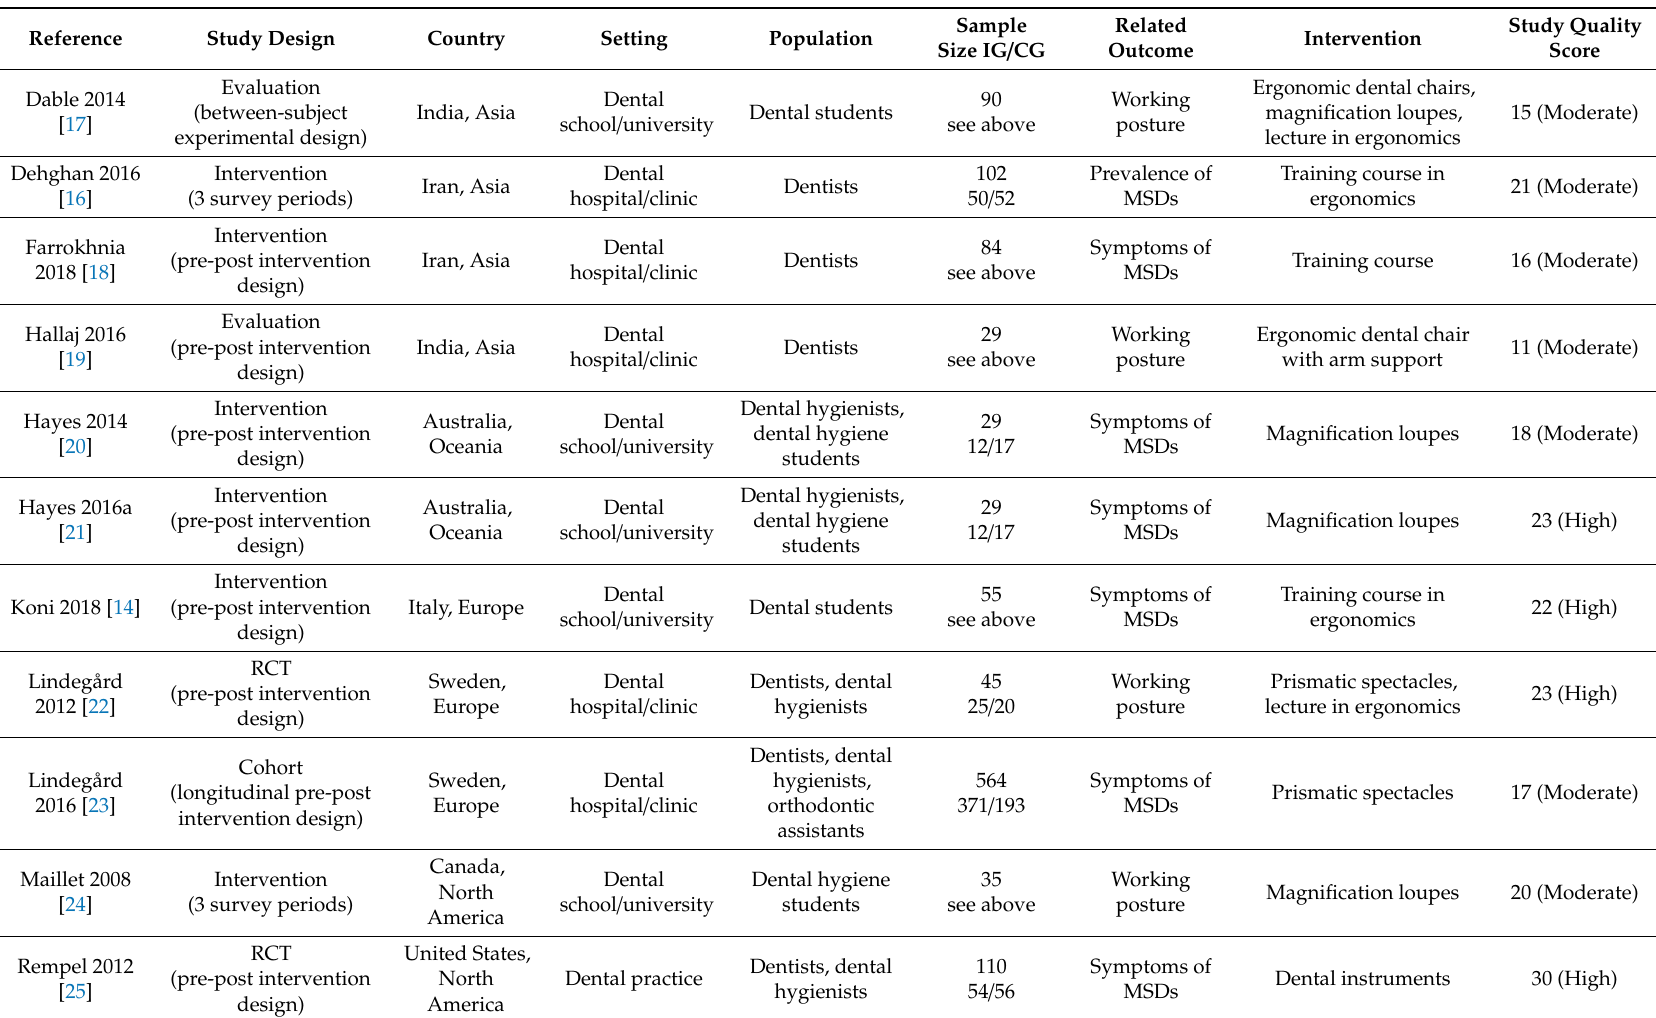
Table 2. Characteristics of the included studies reporting ergonomic interventions to prevent MSDs among dental professionals ( n =